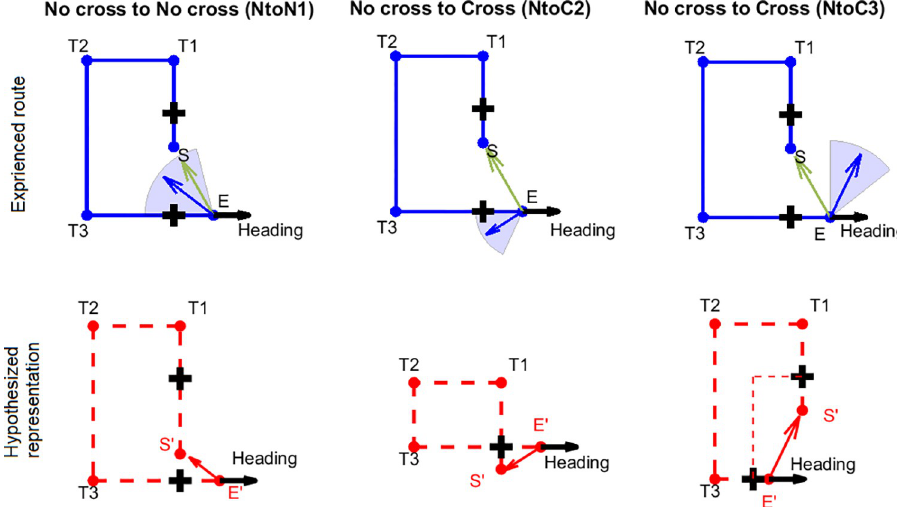
Fig 7. Predicted pointing directions according to each hypothesis for the FI-NC condition in Experiments 2 and 3. The example path is Path 6. Black bold pluses indicate the intersections. Thin red dashed lines (bottom right panel) indicate the extra represented path segments. Other abbreviations and legend are the same as in Fig